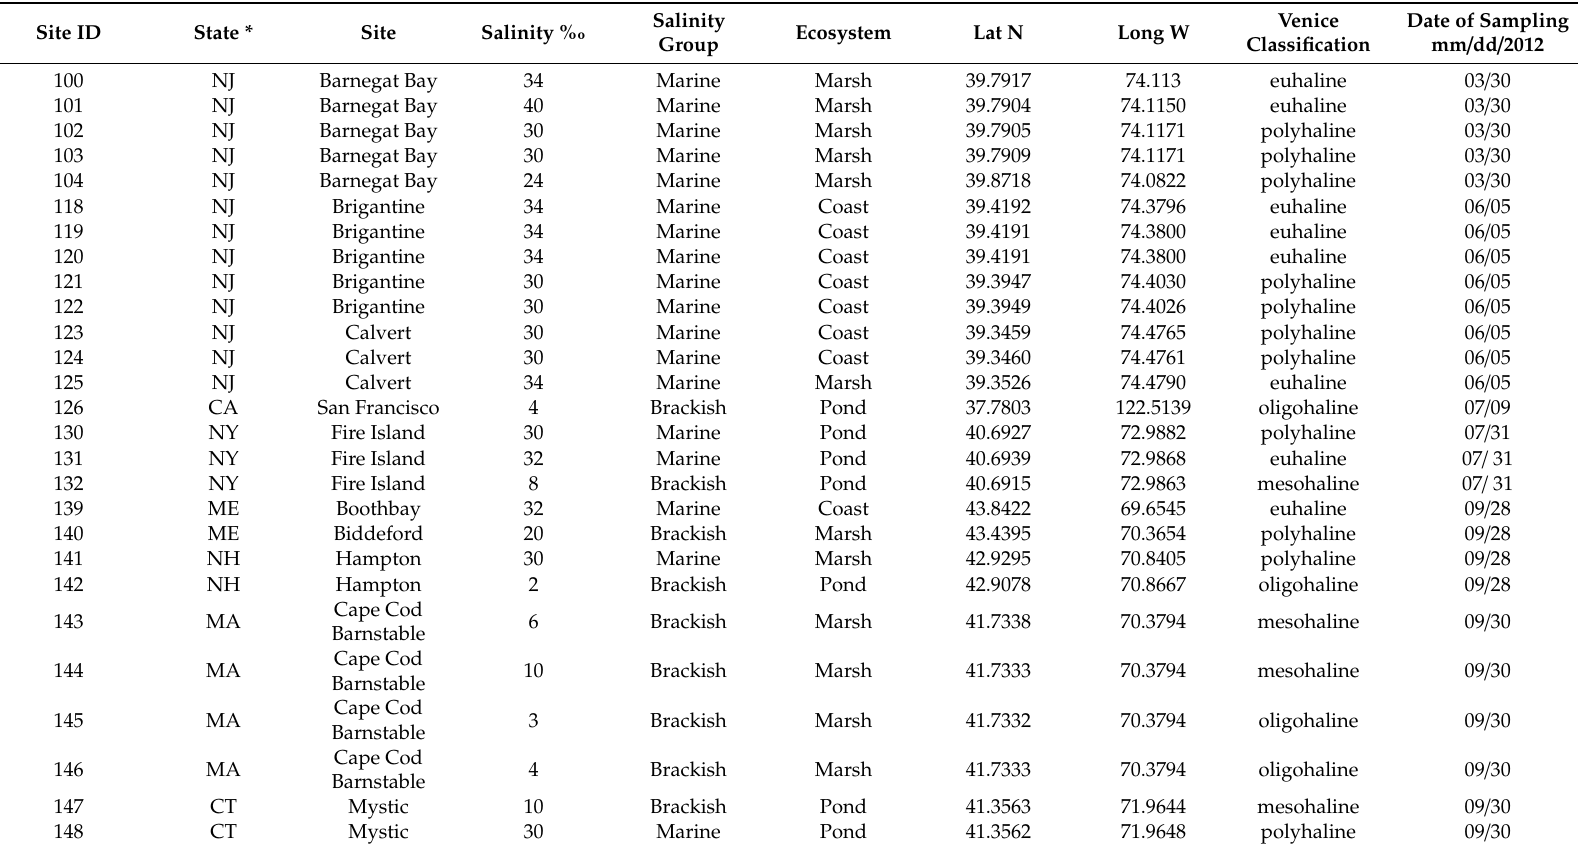
Table 1. List of sites and ecosystems where samples were collected. Coordinates (in decimal degree format), salinity values and classifications, ecosystems, and date of sampling are